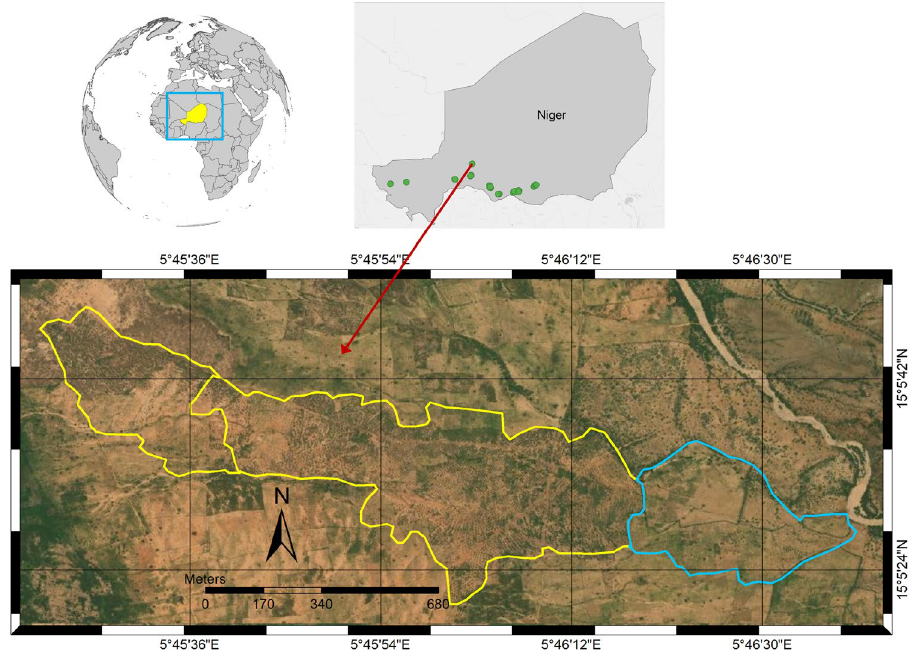
Figure 7. WFP intervention sites in southern Niger include interventions intended for agricultural (blue) and pastoral (yellow) uses. The figure was created using ArcGIS Pro 3 (www.arcgis.come).